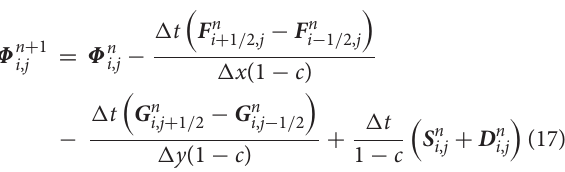
Frontiers in Earth Science |